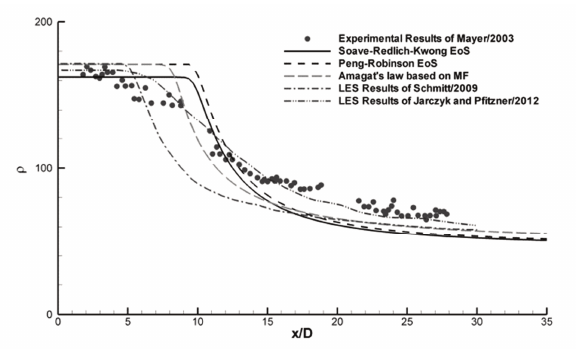
Fig. 7. Axial density distribution for supercritical